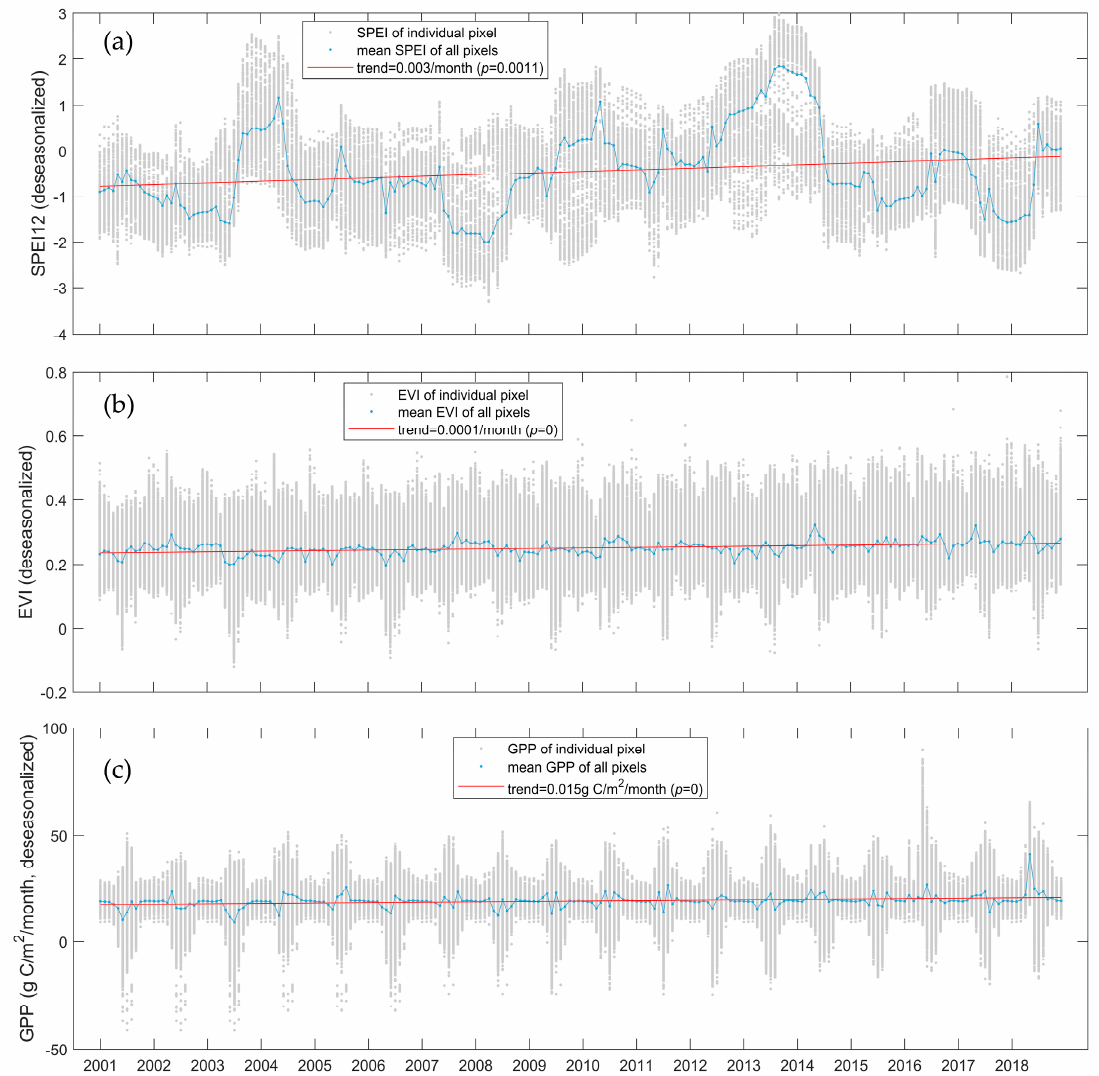
Figure 3. The interannual trend and variation of deseasonalized ( a ) SPEI12, ( b ) EVI, and ( c ) GPP of all valid pixels (gray dots) and the average of all pixels (blue line). The interannual trends are plots with red lines.